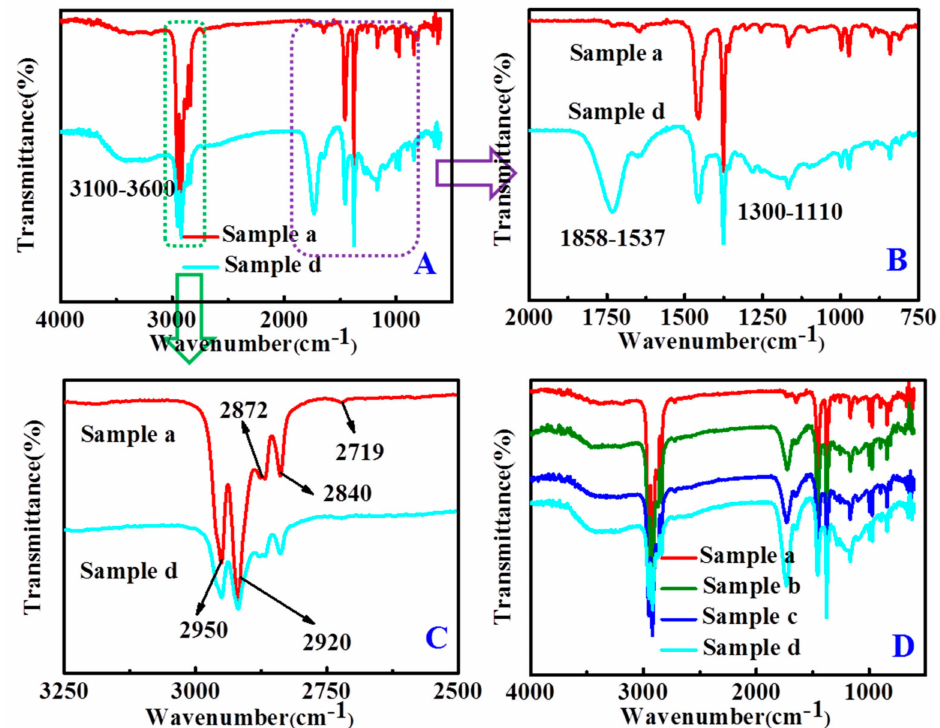
Figure 1. The ATR-FTIR spectra of BOPP films under di ff erent corona treatment conditions. ( A ) is the infrared spectra of sample a and sample d. ( B , C ) is the local magnification of the infrared spectra of sample a and sample d. ( D ) is a comparative infrared spectra of sample a, sample b, sample c and sample